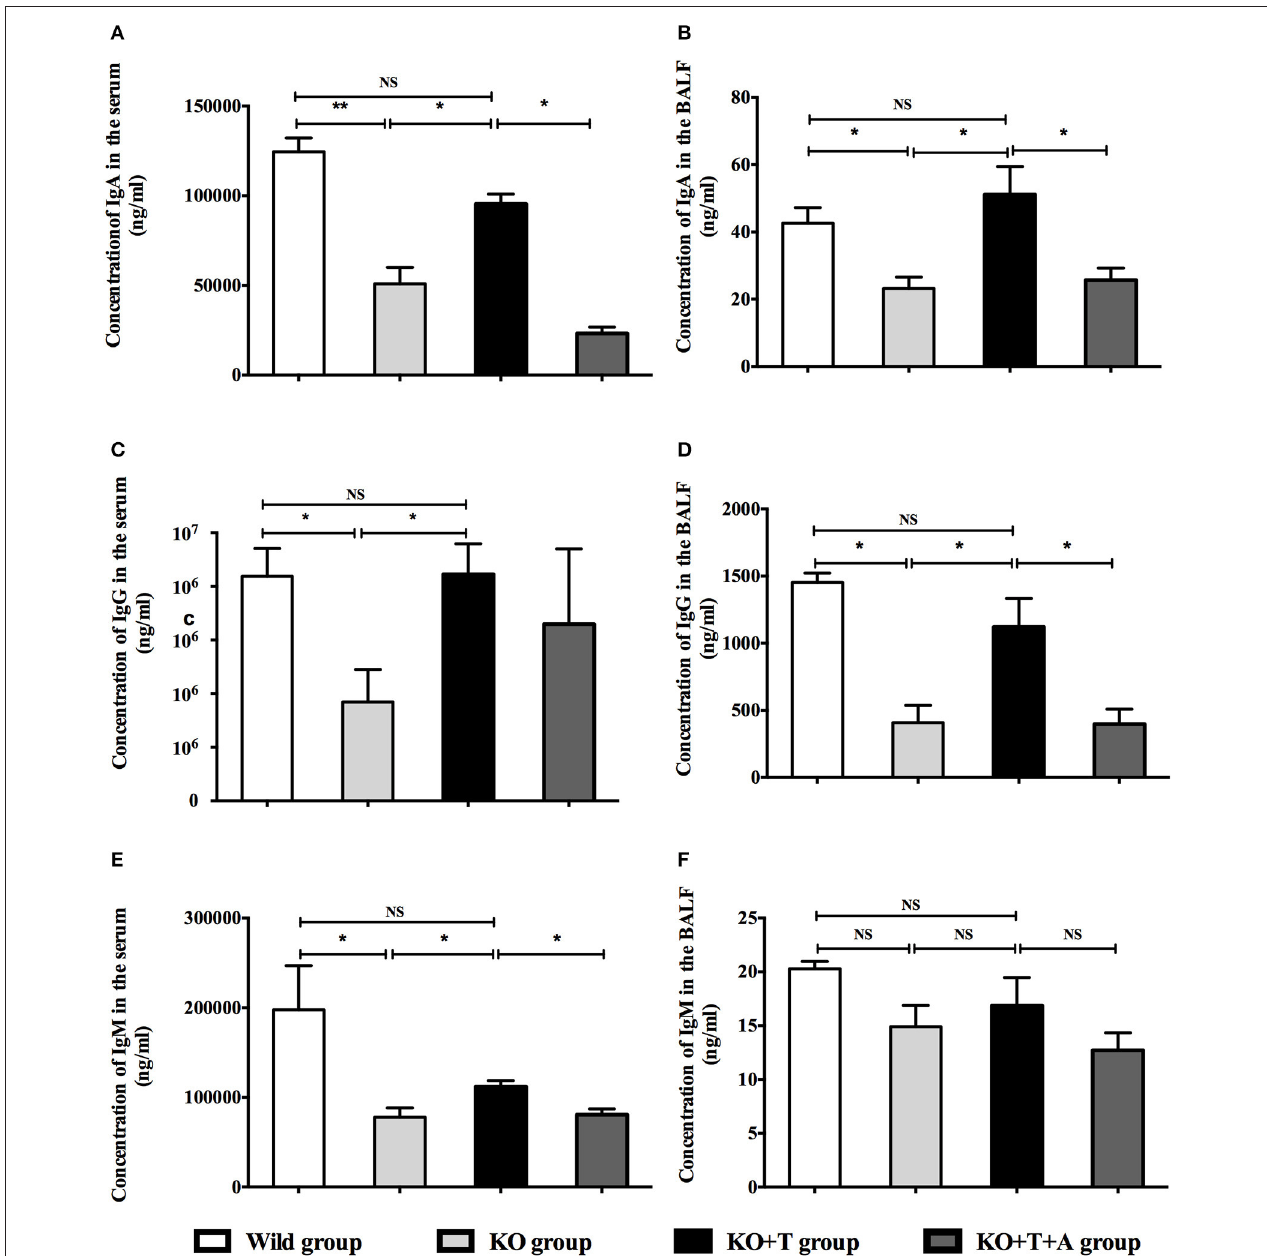
FIGURE 2 | Effect of IL17- γδ T cells on IgA, IgG, and IgM production. The mice were divided into four groups: Wild type (WT) group, γδ TCR − / − (KO) group, γδ TCR − / − transfused with IL17- γδ T cells (KO + T) group, γδ TCR − / − transfused with IL17- γδ T cells pretreated with an anti-IL17 antibody (KO + T + A) group. All mice were inoculated with 20 µ l PAO1 (1 × 10 8 CFU ml − 1 ). The mice in the KO + T group and the KO + T + A group were transfused with IL17-producing γδ T cells (5 × 10 5 cells per mouse) 24 h before infection. Anti-murine IL-17 antibody (100 mg) was first administered 24 h before infection and again 72g after infection in the KO + T + A group. On day 7 post infection, the level of IgA, IgG, and IgM in the serum and BALF of all groups were measured using ELISA. (A,B) Levels of IgA in the serum and BALF. (C,D) Levels of IgG in the serum and BALF. (E,F) Levels of IgM in the serum and BALF. * p < 0.05, ** p < 0.01. These results represent three independent